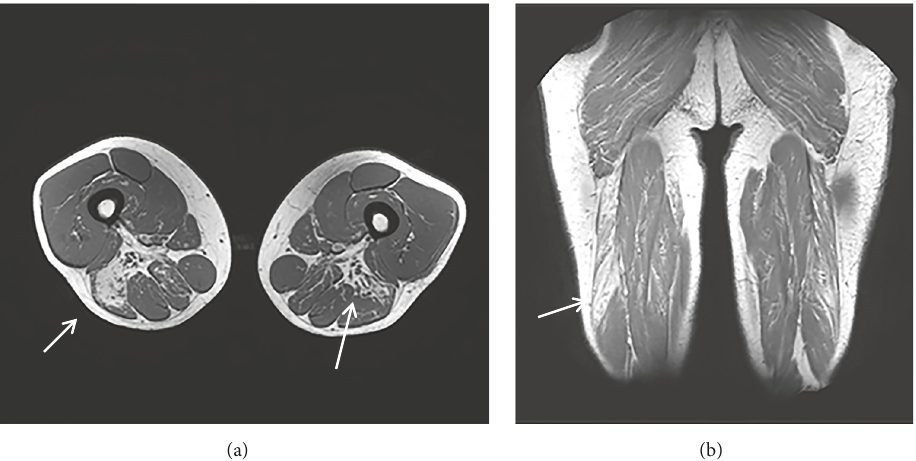
Figure 1: MRI of the thighs in axial T2 (a) and coronal T2 (b) sections shows bilateral fibroadipose degeneration of the adductor and biceps femoris